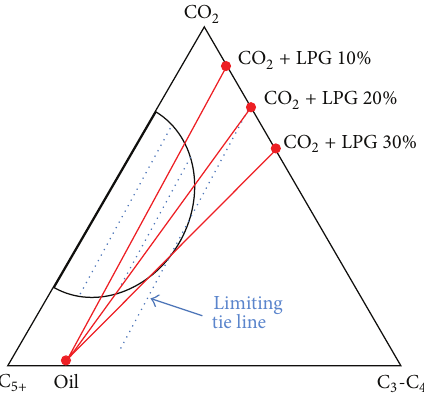
Figure 2: 3D view of simulation model.